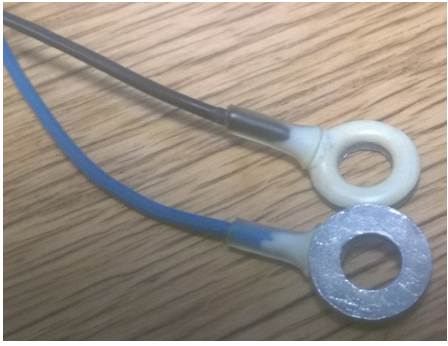
Figure 1. A conventional 1-cm disc EEG electrode made of sintered silver/silver-chloride.